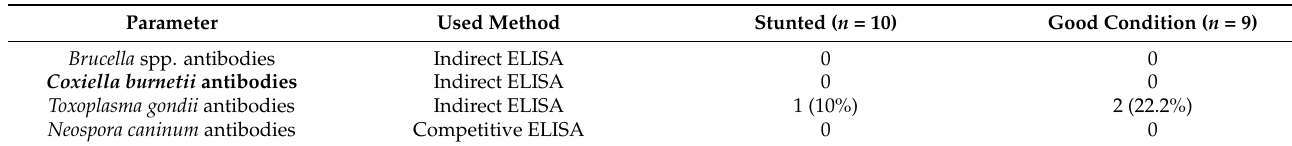
Table 3. Serological testing of Barki sheep in good and poor condition.